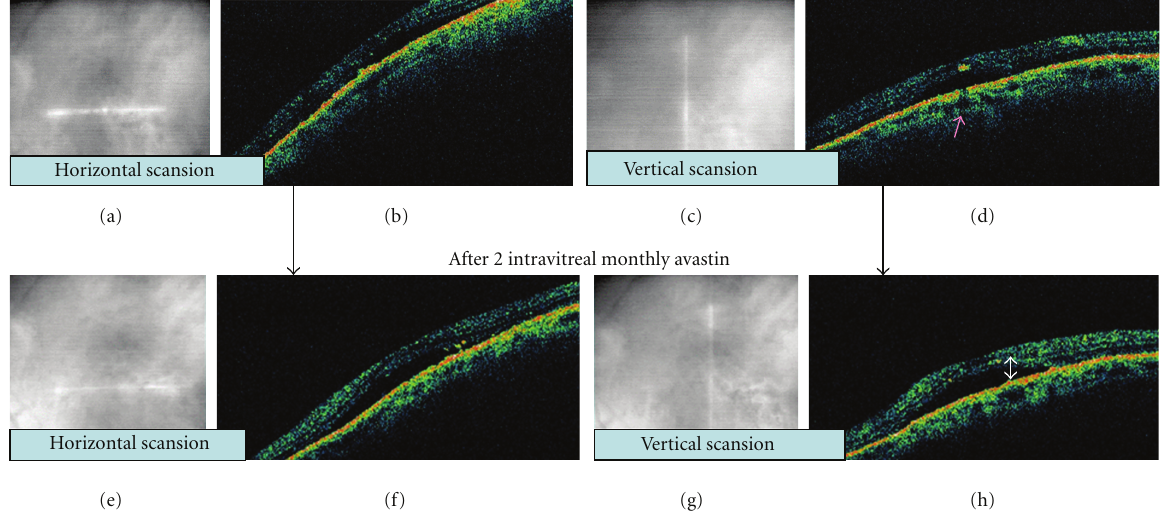
Figure 2: (a), (b), (c), and (d): imaging before intravitreal bevacizumab. (e), (f), (g), and (h): imaging after intravitreal bevacizumab. (a), (c), (e), and (g): infrared imaging shows macular position of OCT scanner at infra-red picture. Serous neuroretinal detachment is well evident in both vertical and horizontal scansion, before (b, d) and after bevacizumab injection (f, h). Presumed focal defect in RPE corresponding to the active leaking point is indicated by the pink arrow. Amount of serous fluid (white arrow) leaking from underling RPE-choriocapillary layer is tomographically